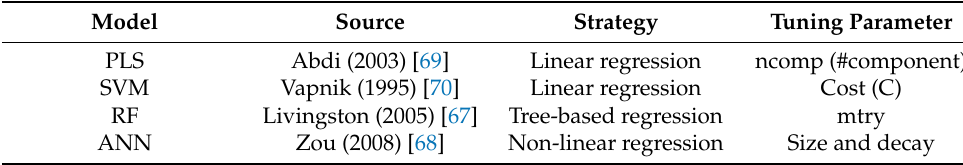
Table 2. Types of models implemented with their tuning